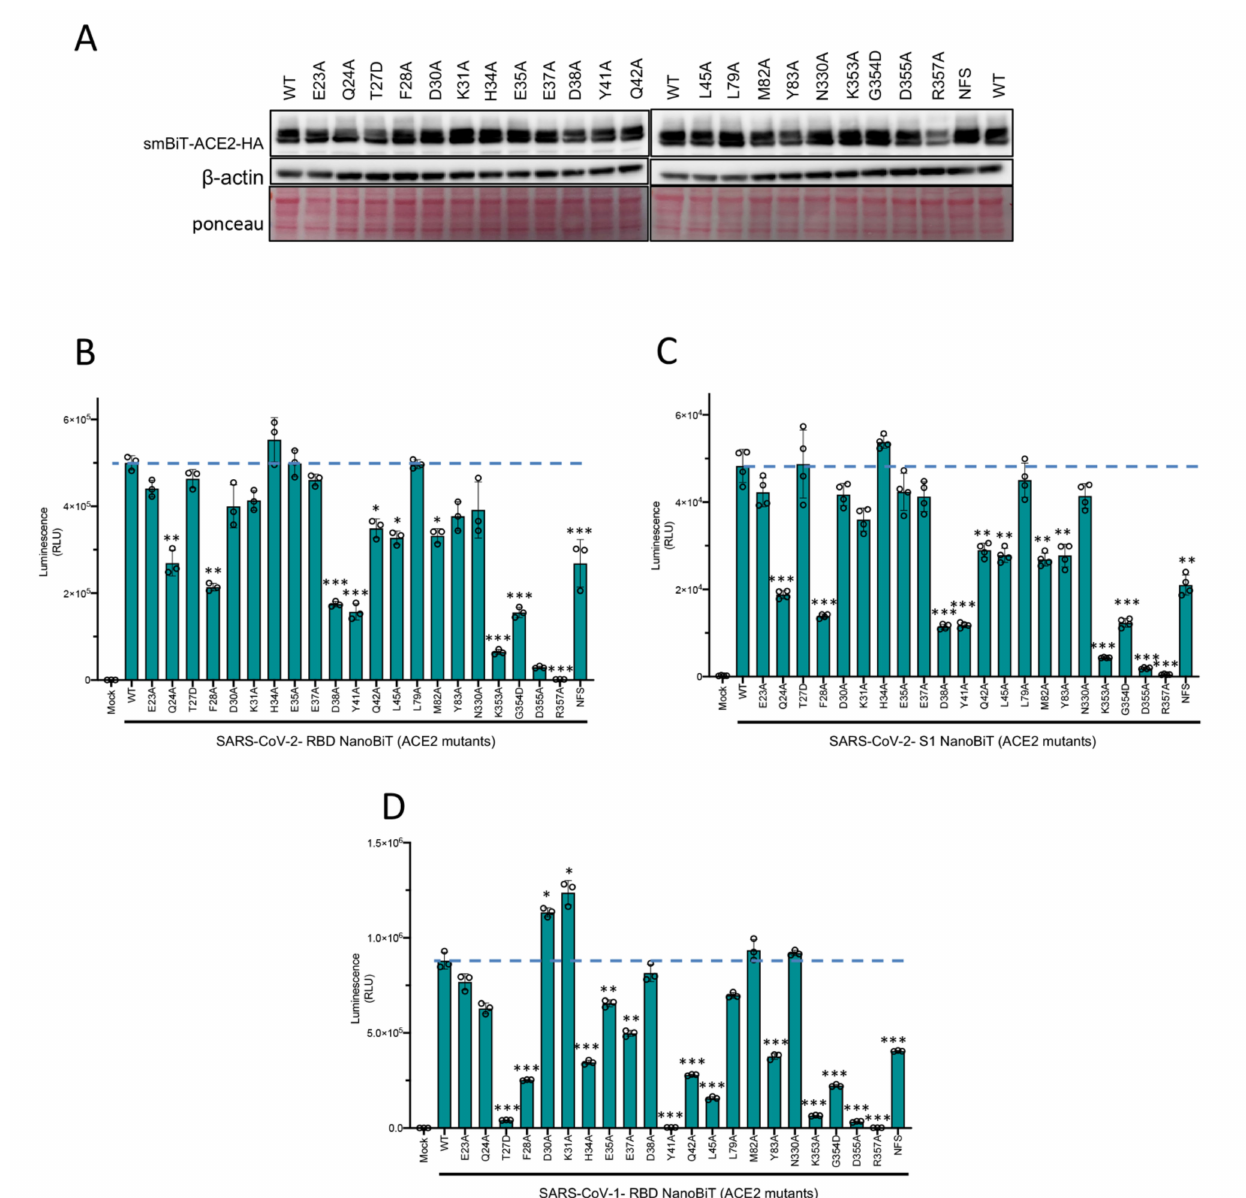
Figure 3. ACE2 mutational analyses with CoV-NanoBiT facilitates delineation of critical host and viral determinants of ACE2–RBD interaction. ( A ) Immunoblot of SmBiT-ACE2 mutant expression from the cell lysates of transfected HEK293T cells. β -actin and total protein loading are shown as controls. ( B – D ) Biosensor assay with SmBiT-ACE2 mutants and ( B ) LgBiT-SARS CoV-2 RBD, ( C ) LgBiT-SARS CoV-2 Spike S1, or ( D ) LgBiT- SARS-CoV-1 RBD demonstrating altered binding affinity of various mutants. * p < 0.05, ** p < 0.01, *** p <